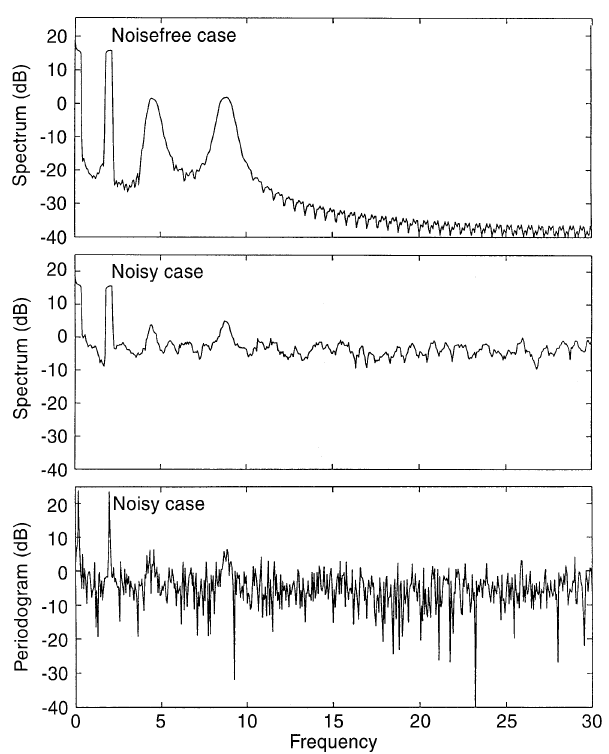
Fig. 1. Thomson’s estimate of the power spectrum of the synthetic signal in the noise-free case ( top ) and in the noisy case ( middle ); the bottom panel is the periodogram; frequencies are in h